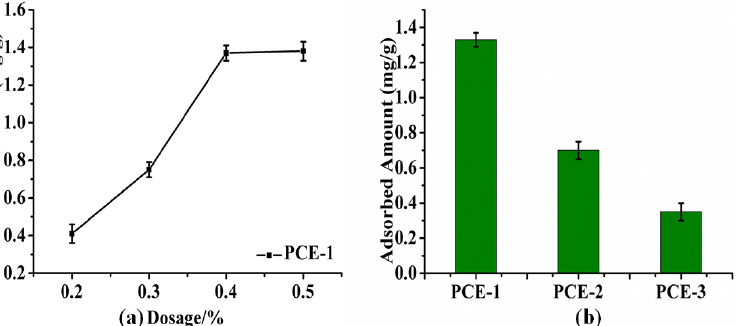
Figure 5. ( a ) Adsorption curve of β -HH with PCE-1 at different dosages; ( b ) adsorption amount of PCEs on β− HH(W/H = 10).